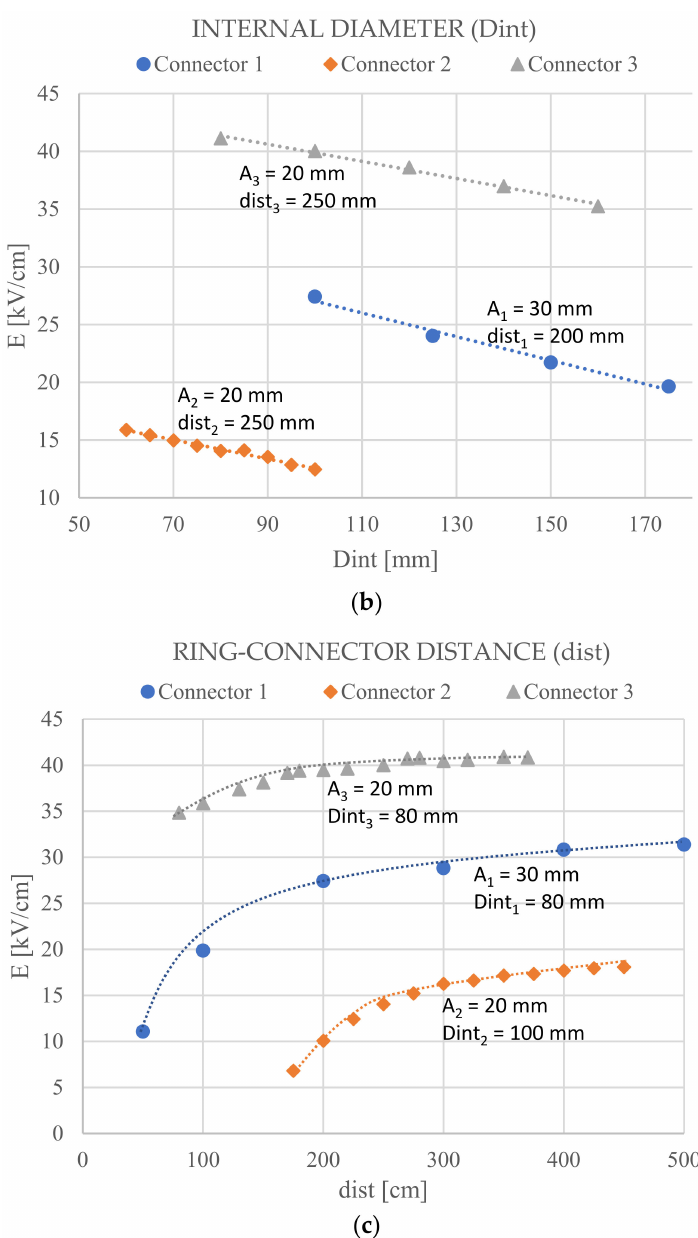
Figure 6. Electric field on the connector’s surface as a function of the ring dimensions: ( a ) ring thickness, ( b ) internal diameter, and ( c ) ring–connector